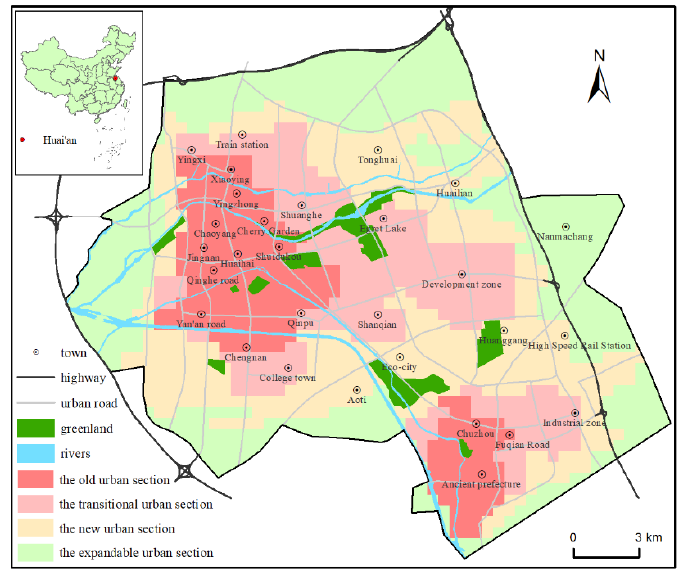
Figure 1. Profile of research